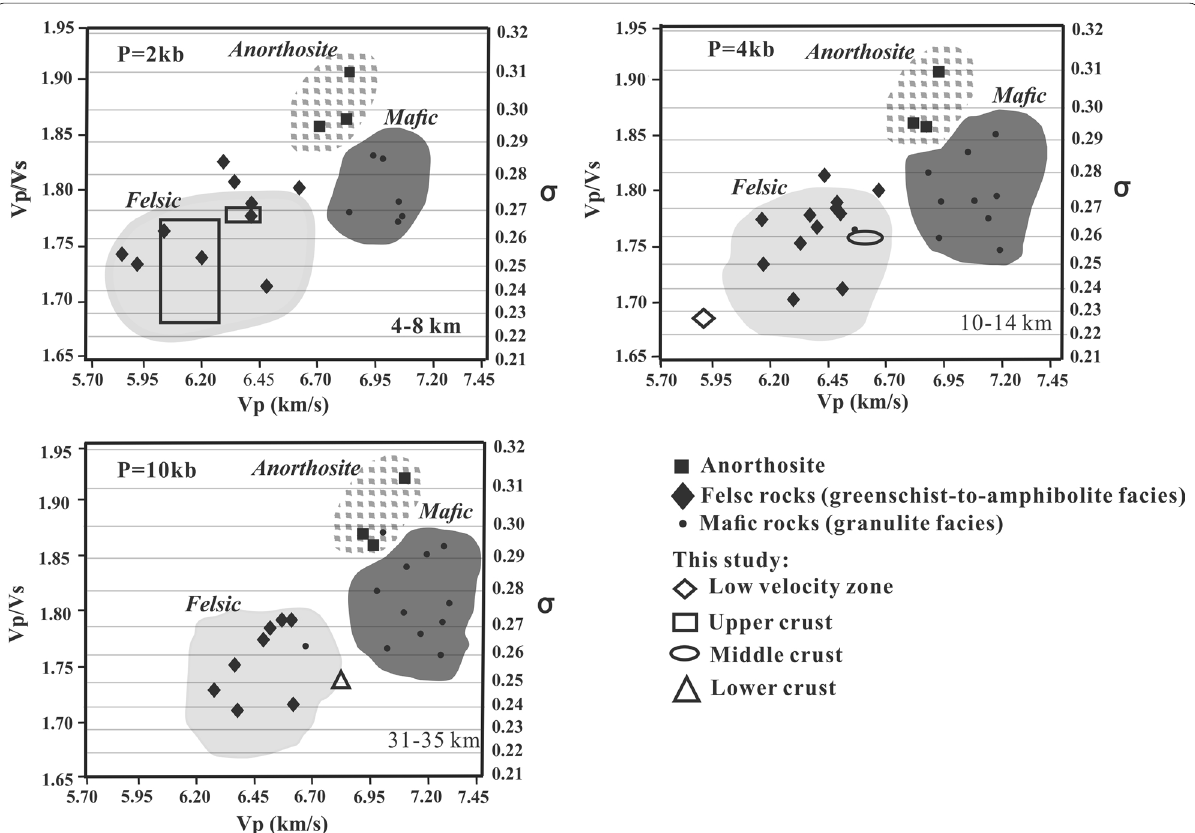
Fig. 13 Vp / Vs and Poisson’s ratio σ versus Vp at pressures characteristic for 4 to 8 km depth (2 kb), 10 to 14 km depth (4 kb), and 31 to 35 km depth (10 kb), based on Musacchio et al. (1997). Solid symbols indicate laboratory measurements on rock samples. Gray-shaded areas indicate domains of felsic, mafic, and anorthosite composite as derived from laboratory measurement. Open symbols indicate values obtained from the Line 1 seismic profile (this